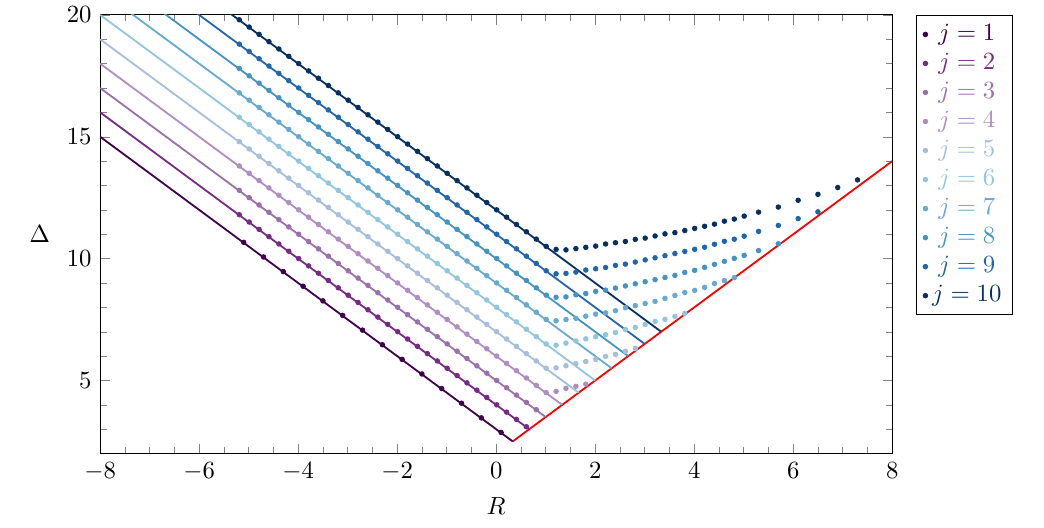
Figure 2 . Plot of the results in (cid:12)gure 1 in the ( R; (cid:1))